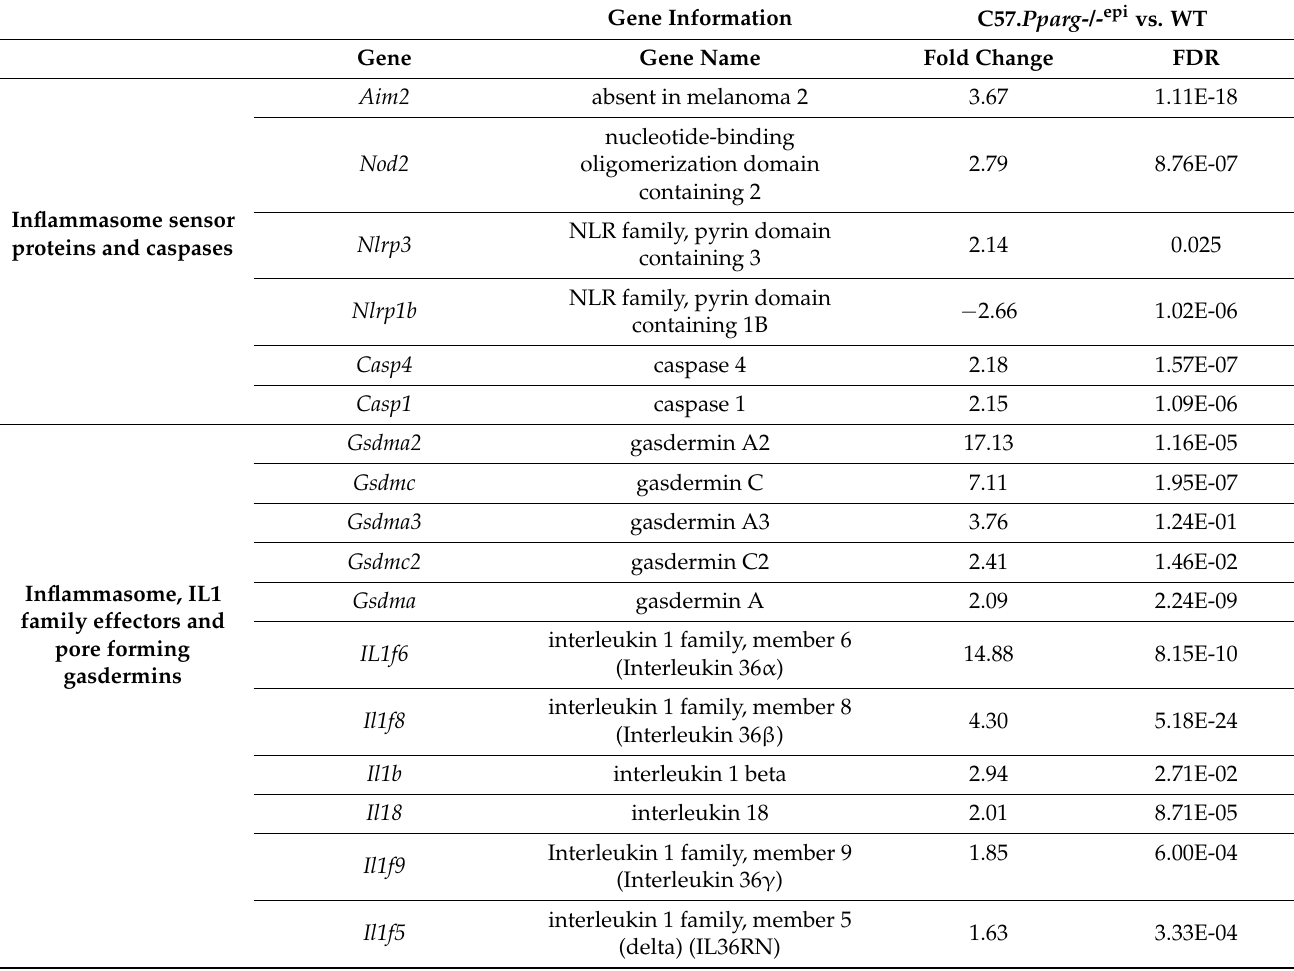
Table 1. Differentially expressed genes that are associated with inflammasome activation and pyroptosis